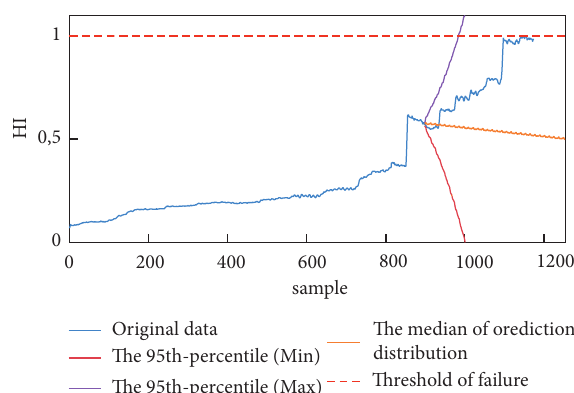
Figure 10: ARIMA-based prediction results for sample 1 (1).